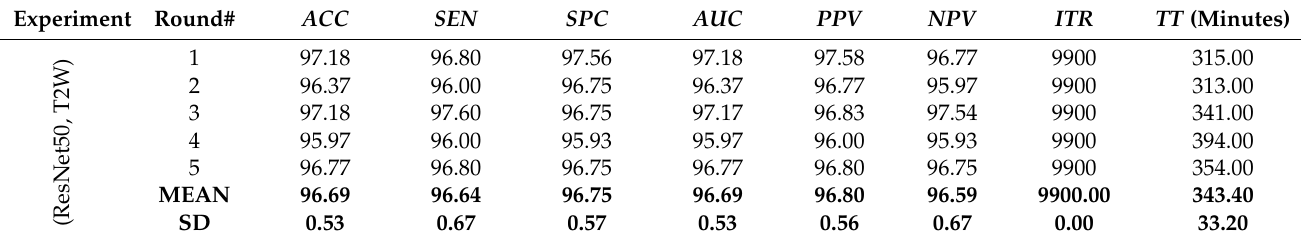
Table A13. Test results of five-folds of the experiment (ResNet50, T2W).